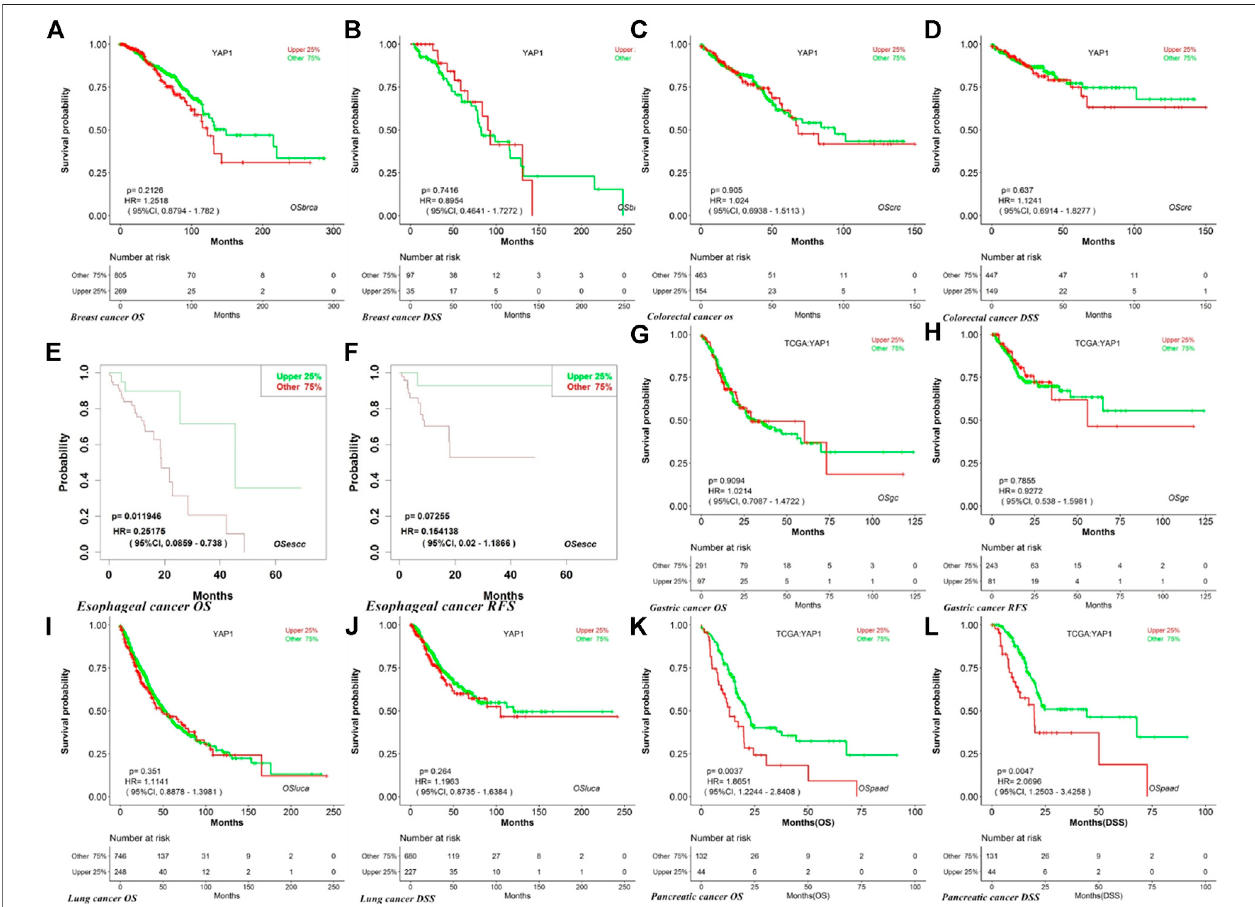
FIGURE6| Kaplan – Meier survivalcurvesforhigh and lowYAP1 expression in differenttypes ofcancerbased on theLOGpcTCCG database.OS, overallsurvival; DFS, disease-free survival; RFS, relapse-free survival; DSS, disease-speci fi c survival. DMFS, distant metastasis-free survival.